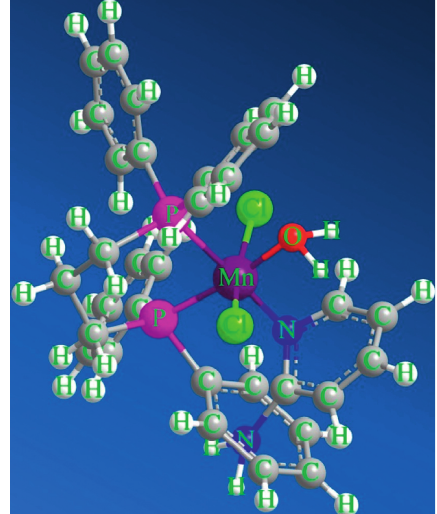
Figure 3: Structure of complexes [M(DPPP)(APY)(H Cl 2 ]. x H 2 O, where M � Ni(II), Cu(II), Mn(II) or Fe(II) and x � 0, 1, or 2 molecules of H 2 O.